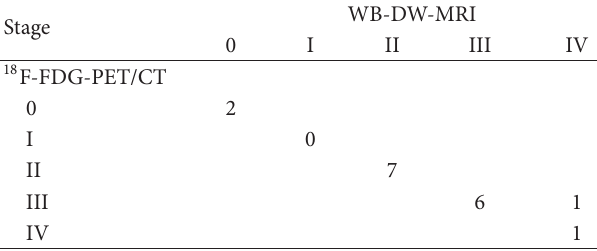
Table 3: Staging of lymphoma provided by WB-DW-MRI and 18 F-